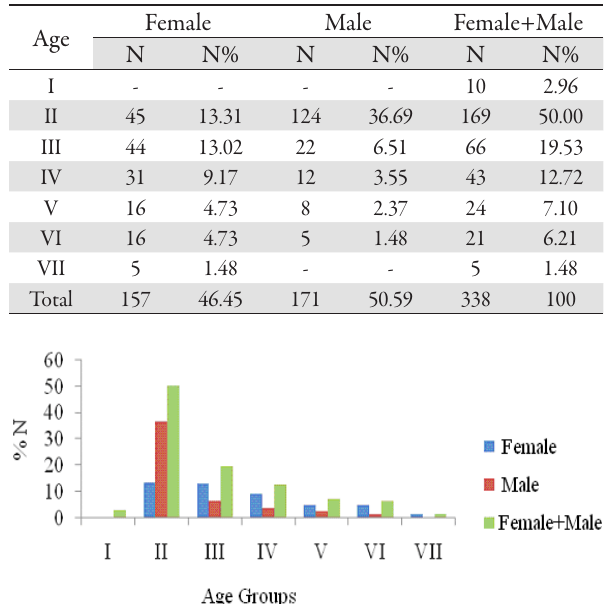
Tab. 1. The age and gender distribution of S. cephalus in